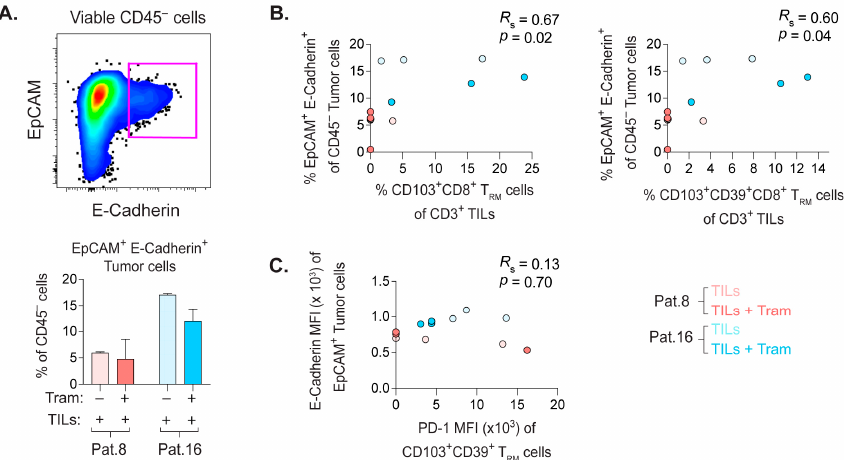
Figure 6. The frequency of E-Cadherin+ tumor cells associated with the percentage of CD8+ T RM cells. ( A ) Gating of EpCAM+ E-Cadherin+ tumor cells from viable CD45– cells and their frequency in tumor implants of indicated groups of PDX mice. ( B ) Non-parametric Spearman correlation analyses of the frequencies of EpCAM+ E-Cadherin+ tumor cells vs. CD103+CD8+ T RM cells or CD103+CD39+CD8+ T RM cells. ( C ) Spearman correlation analysis of the MFI values of E-Cadherin on EpCAM+ tumor cells vs. PD-1 on CD103+CD39+CD8+ T RM cells. Bars show mean with SD. A large variety of human tumors express E-Cadherin (CD103 ligand) [28]. Binding